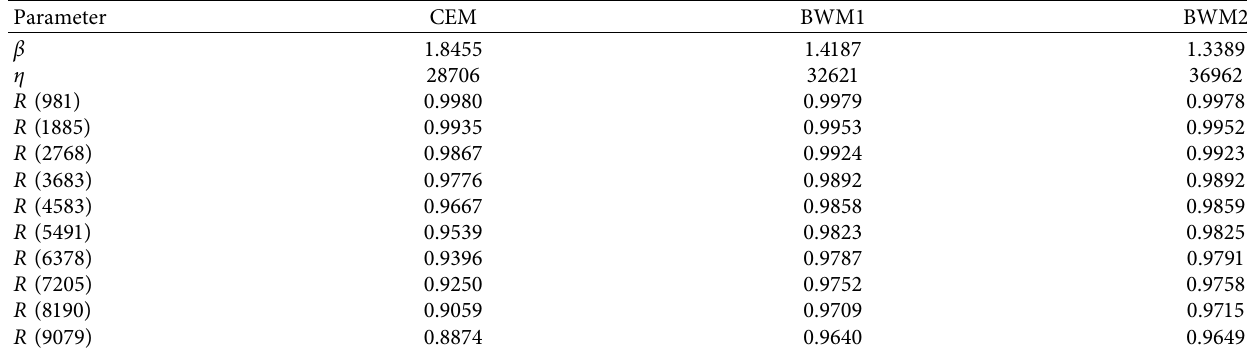
Table 3: Parameter and reliability estimation.